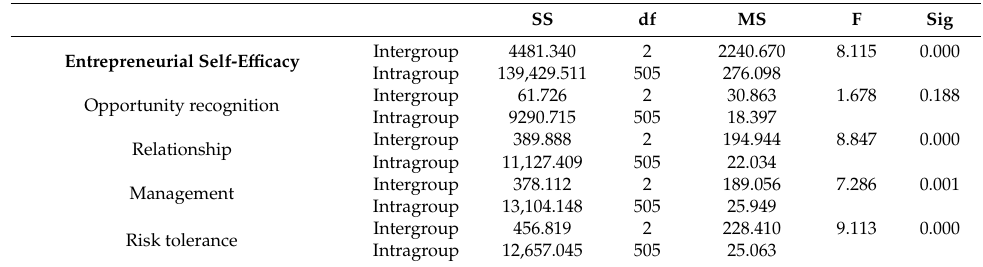
Table 8. Grade di ff erences in entrepreneurial self-e ffi cacy.